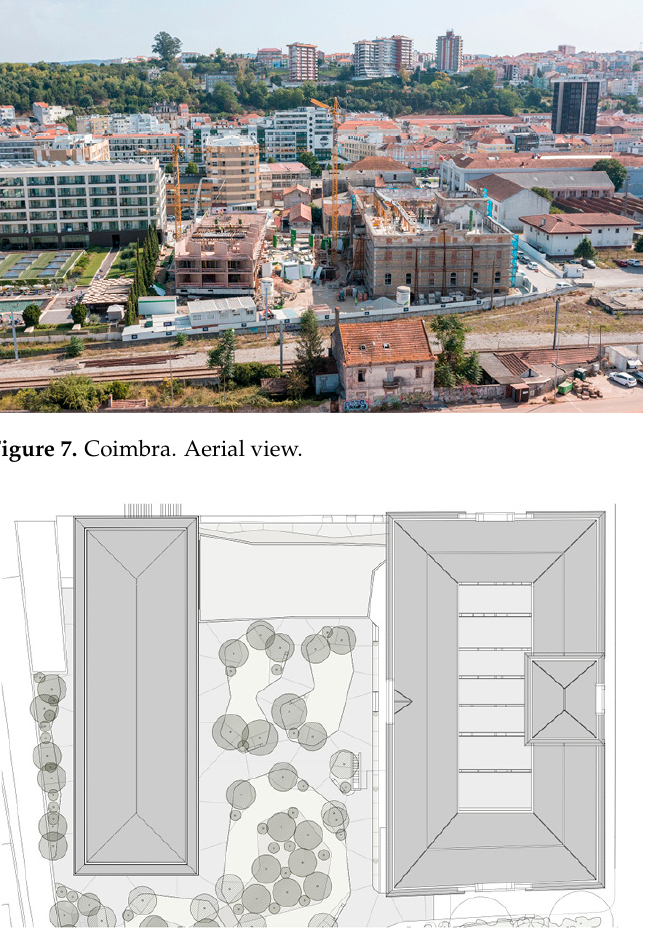
Figure 8. Coimbra. General plan.